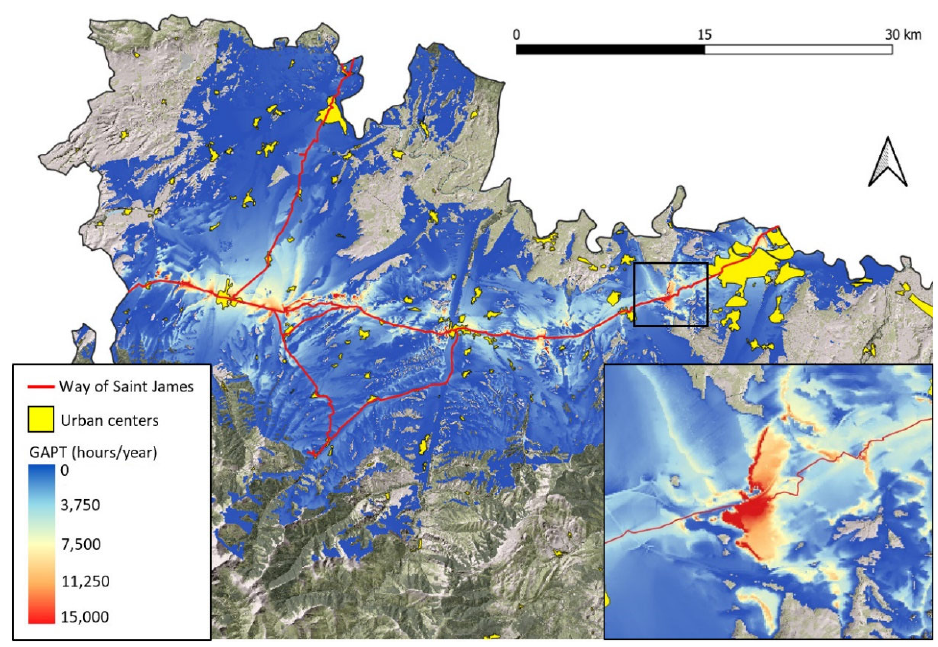
Figure 4. GAPT map, in hours/year, of the study area. the different routes of the Way of St James are represented by red lines. The cells that show the DEM as background (green and grey cells at the top and bottom of Figure 4) represent the areas that have a zero GAPT value and correspond to sites where the PV facilities are not visible from the routes, or to sites that are at a greater distance than the established limit of vision (10 km in our case study). These cells will be the best areas for the location of this type of solar facilities, from the point of view of their low observability from the routes of the Way of Saint James. The blue cells represent the lowest non ‐ zero GAPT val ‐ ues, while the red cells represent the zones with the highest GAPT values and are therefore zones that should be avoided when it comes to the installation of PV plants. We can ob ‐ serve that the cells with higher GAPT values are relatively near the main route (route 1).